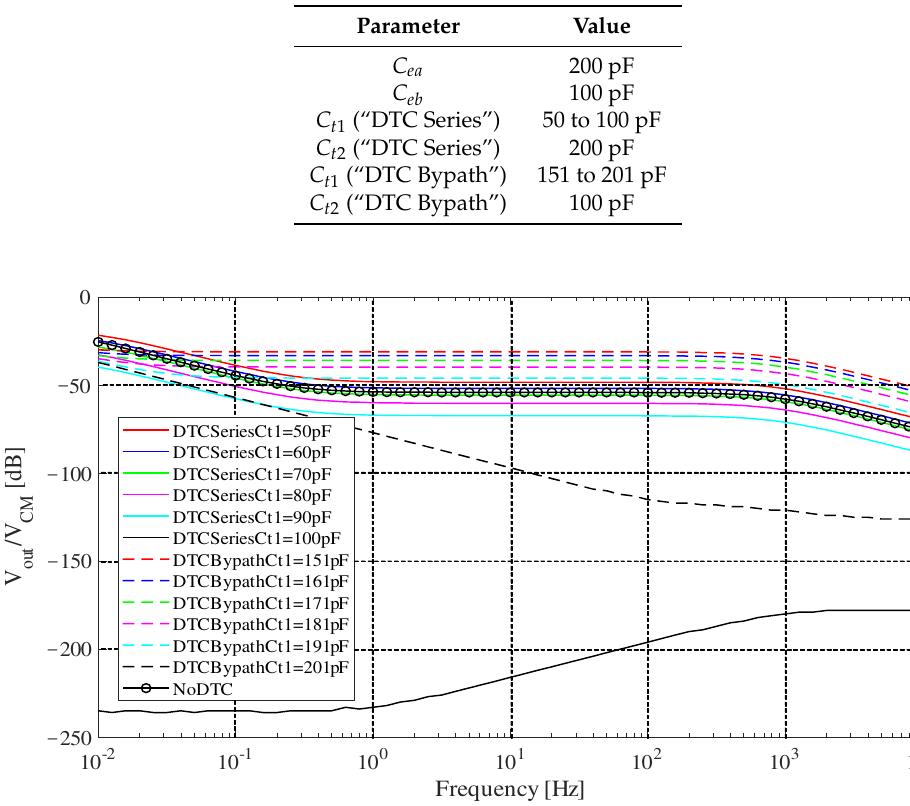
Figure 8. Simulated result of small signal AC sweep under Table 4’s condition. The solid lines show results for “DTC Series”, the dashed lines show results for “DTC Bypath”, “NoDTC” shows the results of no imbalance